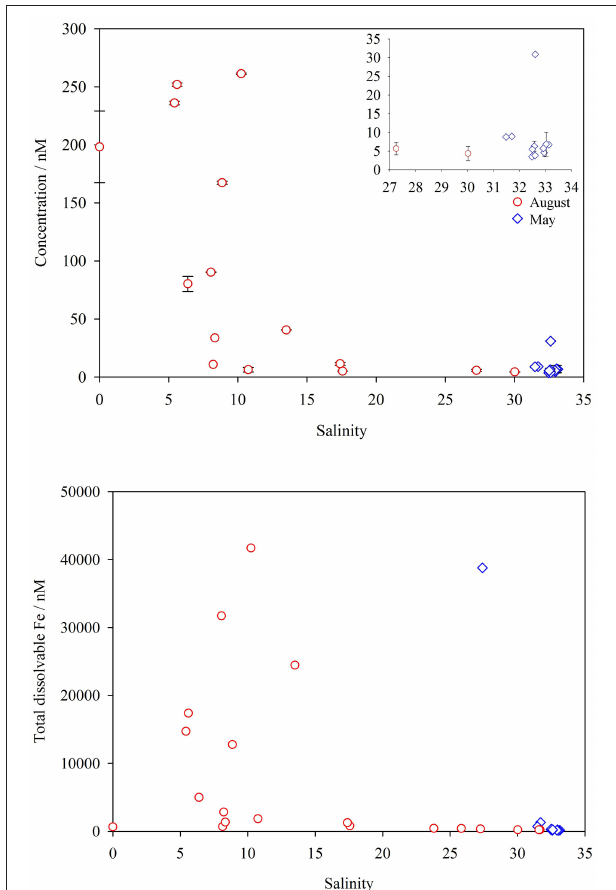
FIGURE 7 | Top: dissolved Fe along the salinity gradient in Godthåbsfjord, including Lake Tasersuaq estuarine waters and runoff, before (May, blue diamonds) and during (August, red circles) the meltwater season. Inset, high salinity stations only. Bottom: total (dissolvable in unfiltered samples at pH < 2.0) Fe concentrations along the salinity gradient in Godthåbsfjord, before and during the meltwater season.